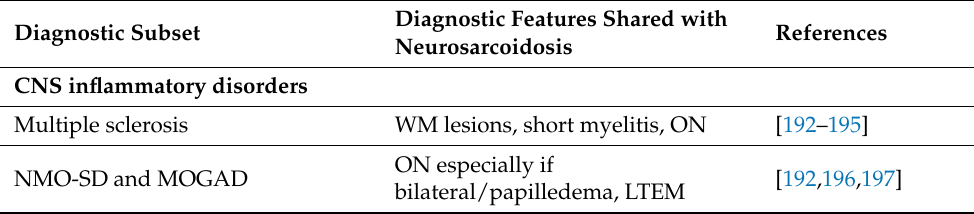
Table 5. Main differential diagnoses of central nervous system